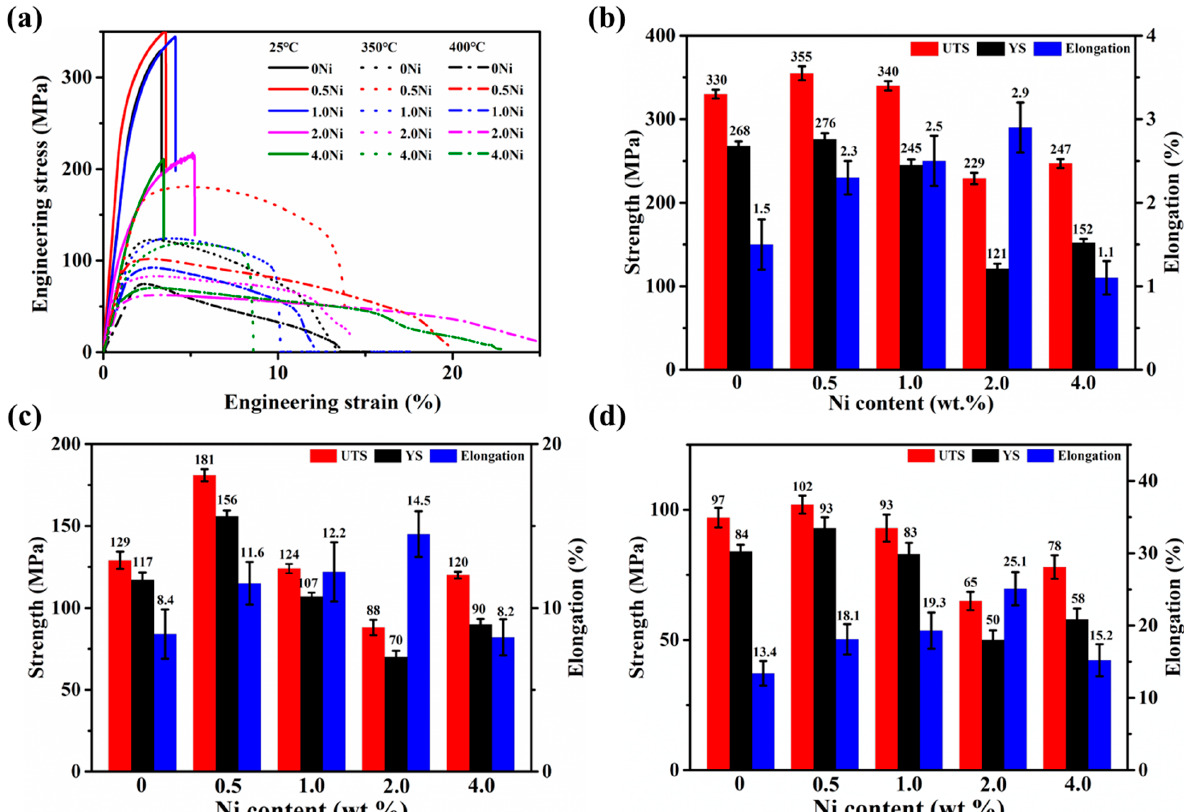
Figure 6. The tensile properties of the heat-treated alloys at different temperatures: ( a ) the engineer- ing stress-strain curves at different temperatures, ( b ) 25 °C, ( c ) 350 °C, ( d ) 400 °C. stress-strain curves at different temperatures, ( b ) 25 ◦ C, ( c ) 350 ◦ C, ( d ) 400 ◦ It turns out that adding 0.5% Ni to the alloy can improve the mechanical properties.